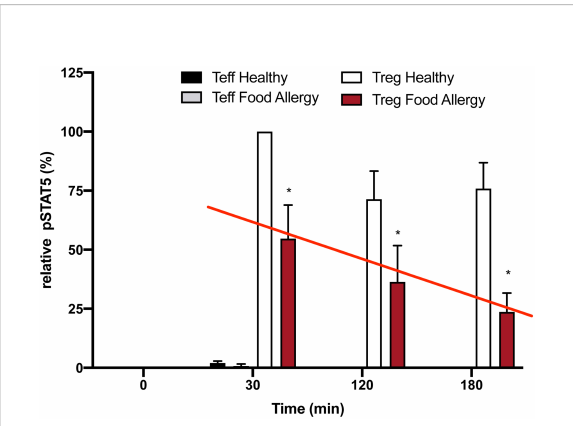
FIGURE 9 Loss of inhibition of T reg IL-2R desensitization in food allergy patients. Expression of pSTAT5 in human T effs vs. human T regs in healthy and food allergy participants (n=3/group). Expression of pSTAT5 is shown relative to levels measured in T regs of healthy controls stimulated with low dose IL-2 (1 ng; 25 IU/ml) for 30 mins. Cultures were harvested at the indicated times after stimulation and pSTAT5 levels were measured by immunoblotting. Data are normalized to levels measured in 30 min IL-2 stimulated control T regs. (mean ± S.D.; p < 0.05 for * with two-way